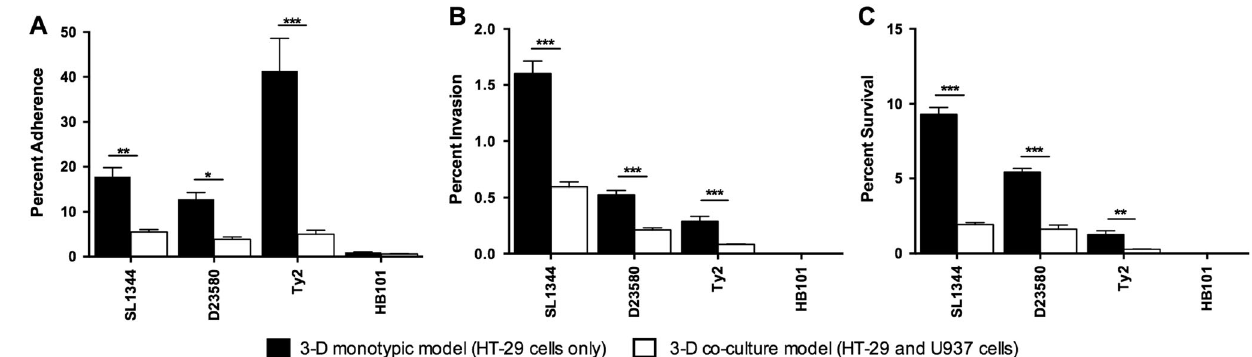
Fig. 3 Salmonella pathovars colonize 3-D co-culture model at lower levels than 3-D epithelial model. Bacteria were cultured under microaerobic conditions. Triplicate wells of either the co-culture ( white bars ) or epithelial model ( black bars ) were infected at an MOI of ~10:1. Following infection, host cells were incubated for either A 30 min (adherence), B 3 h (invasion), or C 24 h (intracellular survival). For each time point serial dilutions of the host cell lysate were plated to assess CFU/mL. All data were normalized to the initial bacterial inoculum for each strain. Error bars represent the standard deviation from two biological replicates, each conducted in technical triplicate. Statistically signi fi cant differences for each strain between the co-culture and epithelial models are indicated as (*) p < 0.05; (**) p < 0.01; or (***) p <